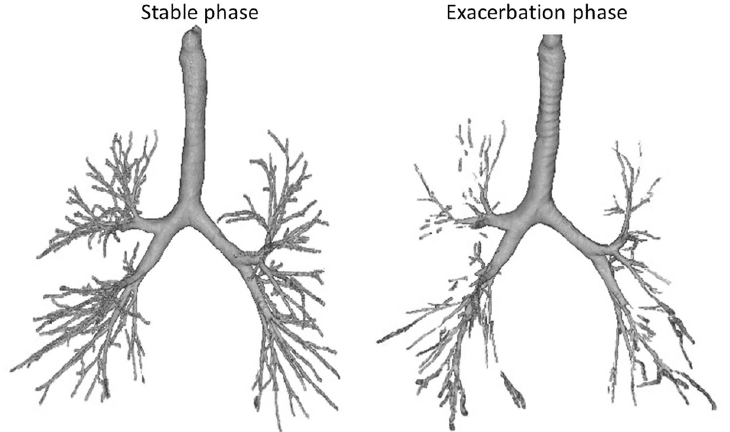
Fig 2. Representative view of bronchial trees by HRCT of the same asthma patient in the stable phase and asthma exacerbation. During the exacerbation phase, the tracheal smooth muscles are constricted, and the tracheal cartilage is visible. Parts of the peripheral airways could not be traced, and middle-zone airways are thin or occluded at exacerbation.